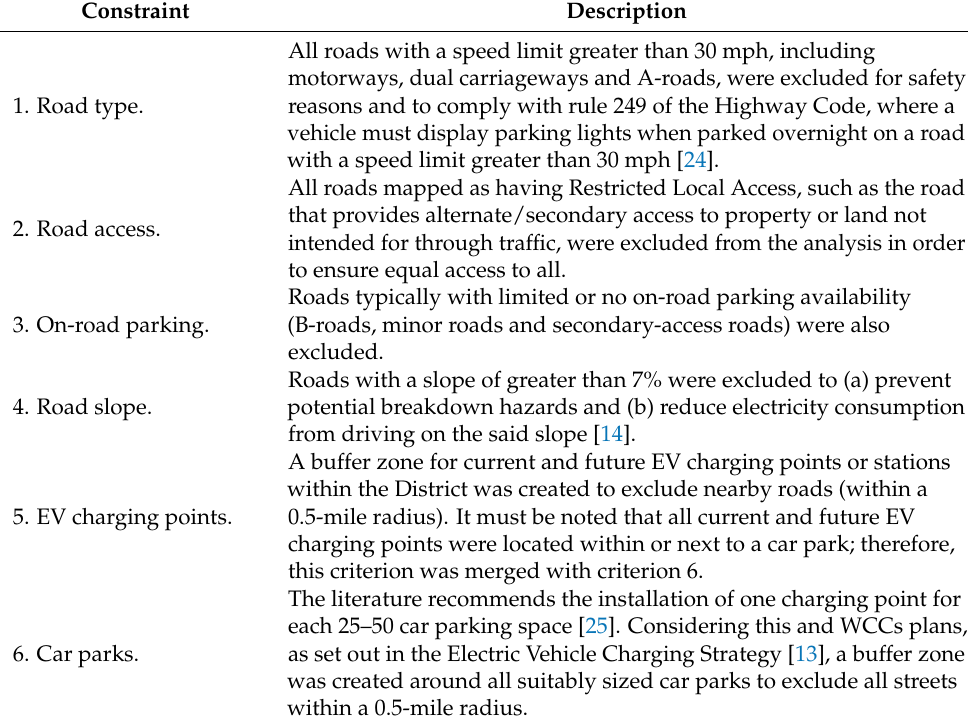
Table 2. Table of constraint/restriction criteria.